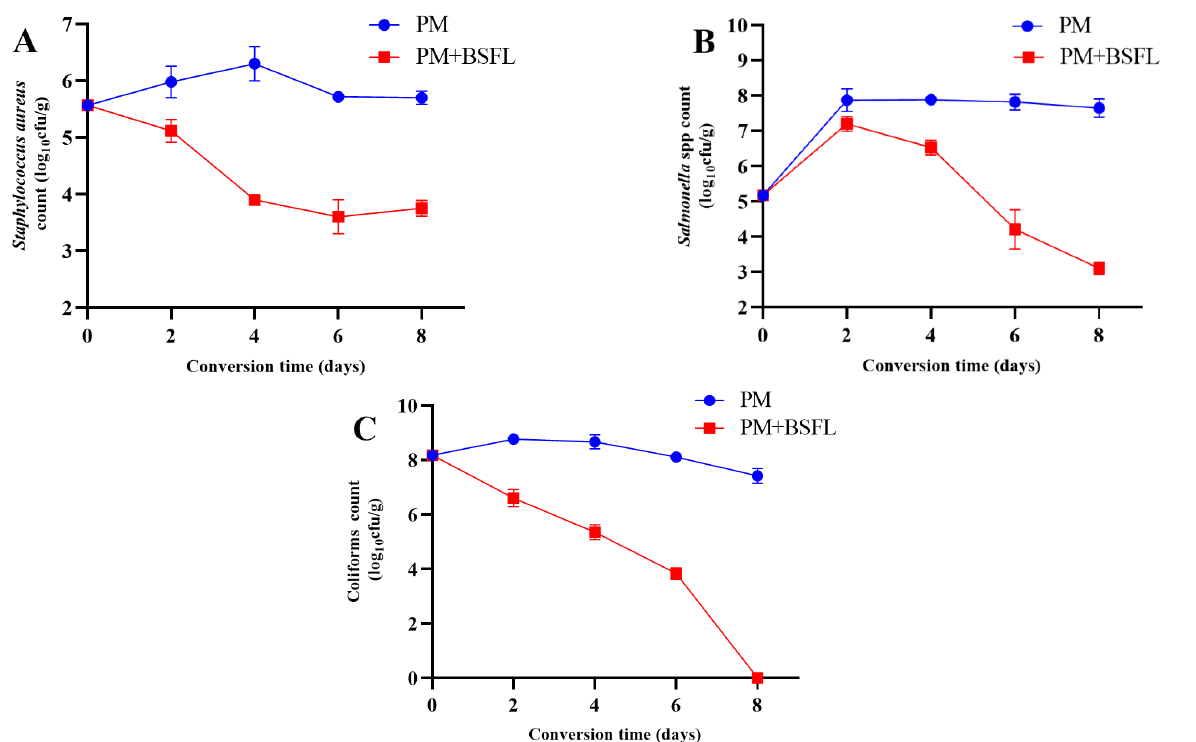
Figure 1. Black soldier fly (BSF) larval inactivation of Staphylococcus aureus ( A ), Salmonella ( B ), and coliforms ( C ) in pig manure. Each point represents the mean of three independent trials (n = 3).